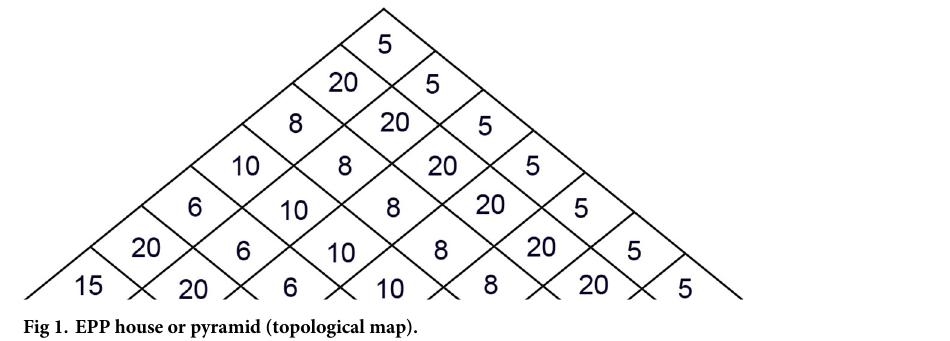
Fig 1. EPP house or pyramid (topological map).